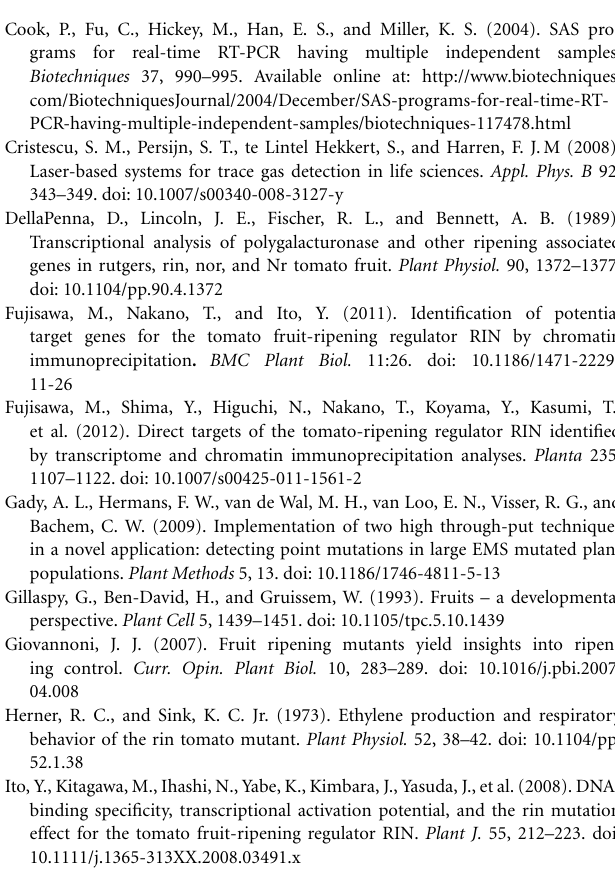
FIGURE 4 | Relative expression levels of ripening related genes in wild-type and mutant fruits. (A) ACS2 ; (B) ACS4 ; (C) PG ; (D) EXP1 ; (E) PSY1 ; (F) ACS6 . In all cases, the expression level of the gene in the wild type